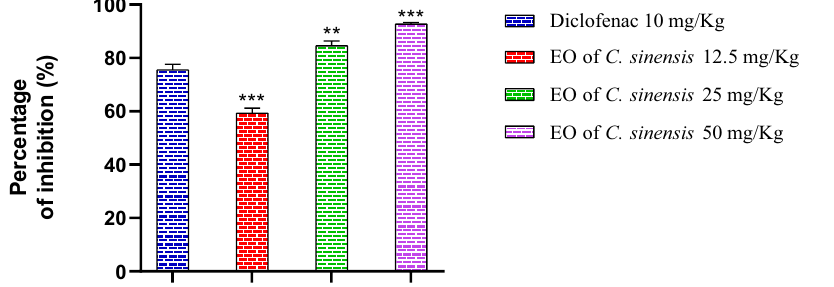
Figure 2: Analgesic activity of the C. sinensis ’ s essential oil of by the writhing method. The values are expressed as mean ± SD ( n = 5 ) . ** P < 0.01, *** P < 0.001 compared with positive control ( one way ANOVA with Tukey test )